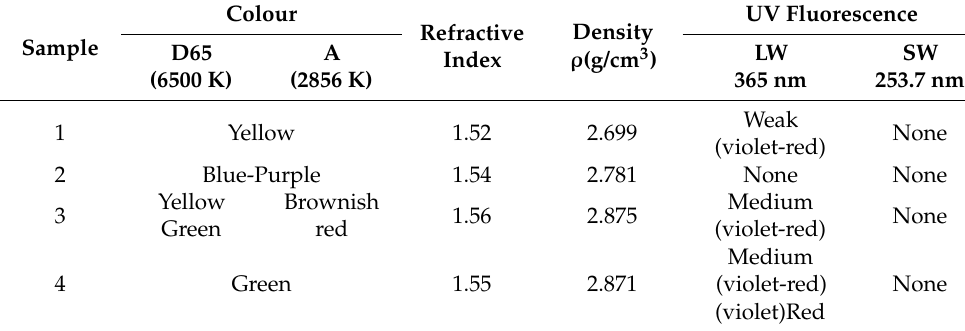
Table 2. Basic physical properties of imitation gemstone glass